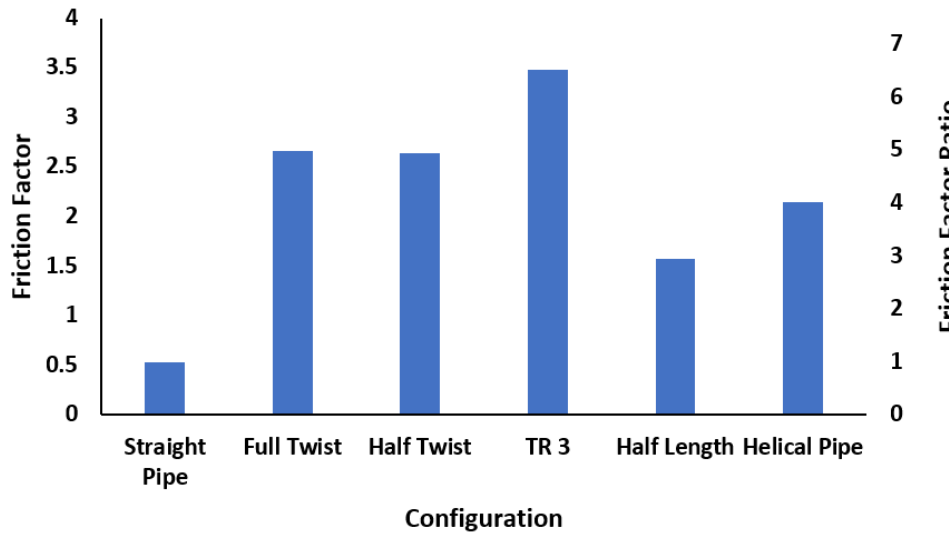
Figure 11. Friction factor of the various configurations.